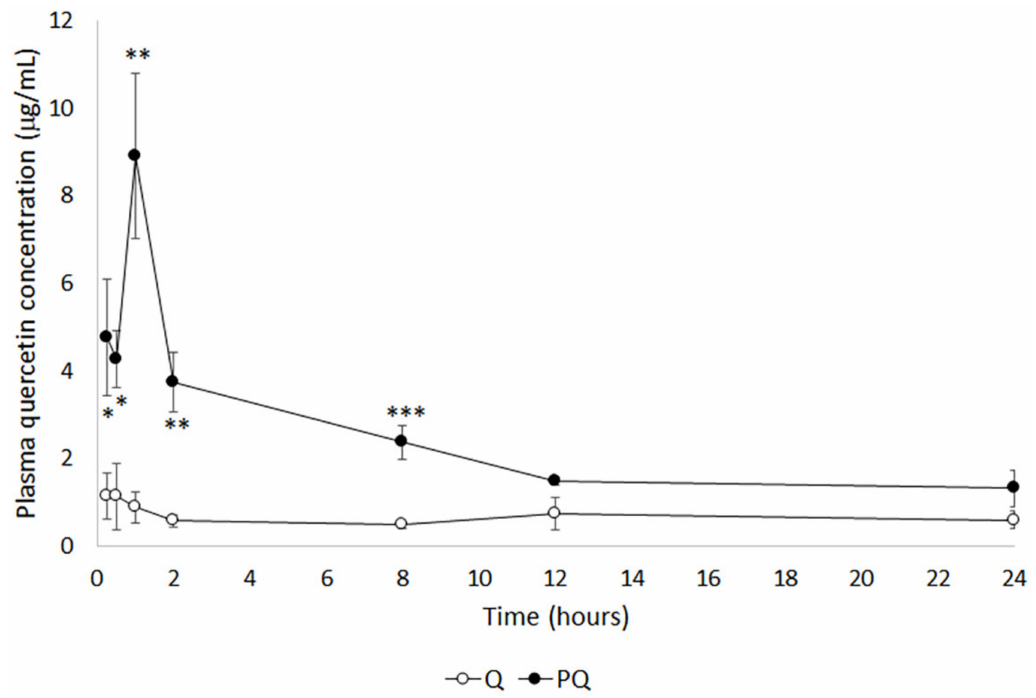
Figure 1. Evolution of the plasma concentration of quercetin after intraperitoneal administration of a single bolus of equimolar P-quercetin and natural quercetin. Values are expressed as the mean ± standard error of the mean (SEM) ( n = 5 per group). * p < 0.05; ** p < 0.01; *** p < 0.001 vs. Q group. Q: quercetin (50 mg/kg, i.p.); PQ: 100 mg/kg i.p. P-quercetin (containing 50 mg/kg